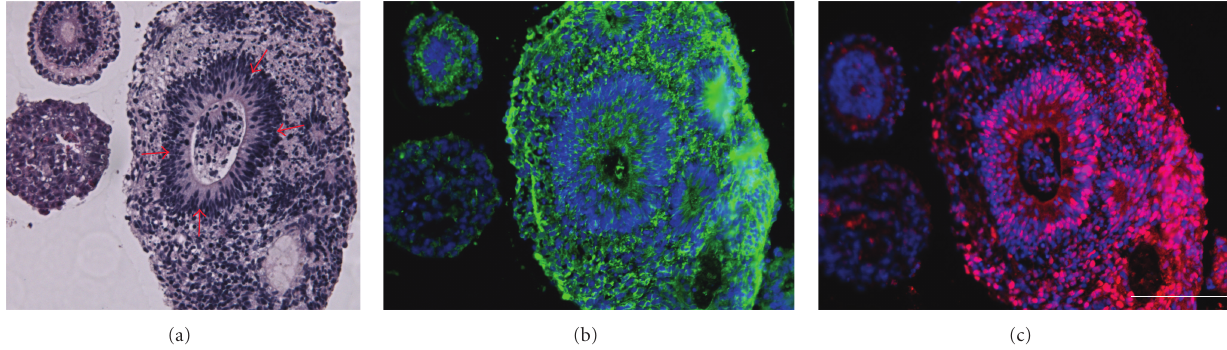
Figure 3: Immunohistochemical analysis of embryoid body sections confirming neuroepithelial tissue in adjacent sections, hematoxylin, and eosin-stained neural rosettes in hiPSCs-derived EBs (a), antinestin immunofluorescent staining (b), green-nestin, blue-nuclei stain, and anti-Sox2 immunofluorescent staining (c), red-Sox2, blue-nuclei stain. Magnification is 400x total (10x ocular, 40x objective). Each scale bar represents 50 μ m in